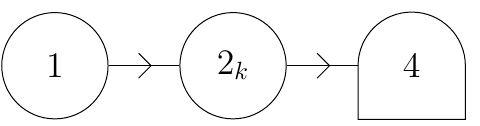
Figure 9 . The quiver diagram representing the defect SU(4)[1,1,2] with a CS term on the U(2) node.